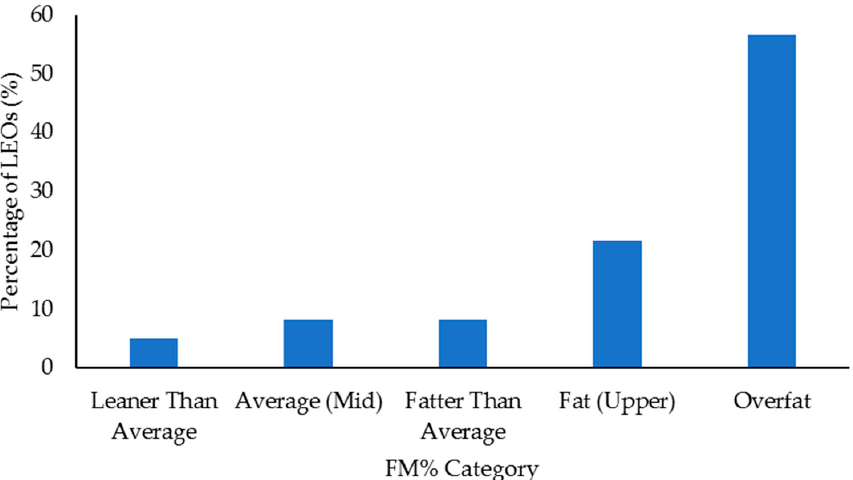
Figure 2. Percentage of law enforcement officers (LEOs) in this sample ( n = 60) classified according to the percentage of fat mass (FM%) categories.